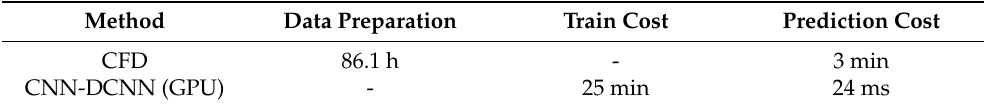
Table 5. Comparison of time cost for the physical field prediction by the CNN-DCNN model and CFD simulation. The GPU is RTX 3080.